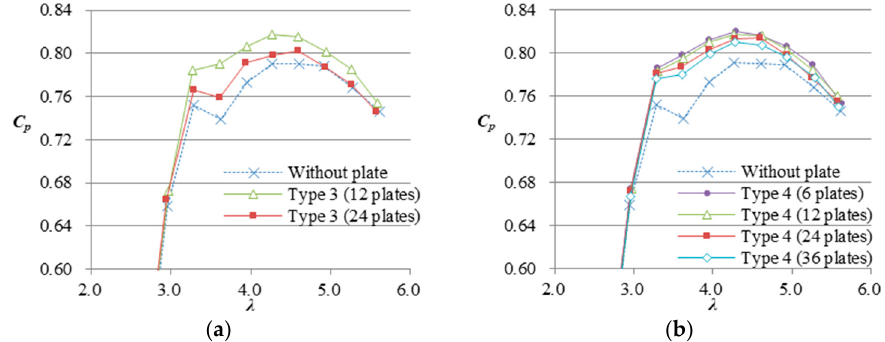
Figure 11. Power curves of WLT Ci10: ( a ) Results of the WLT with the type 3 vortex stabilizing plates; ( b ) Results of the WLT with the type 4 vortex stabilizing plates.